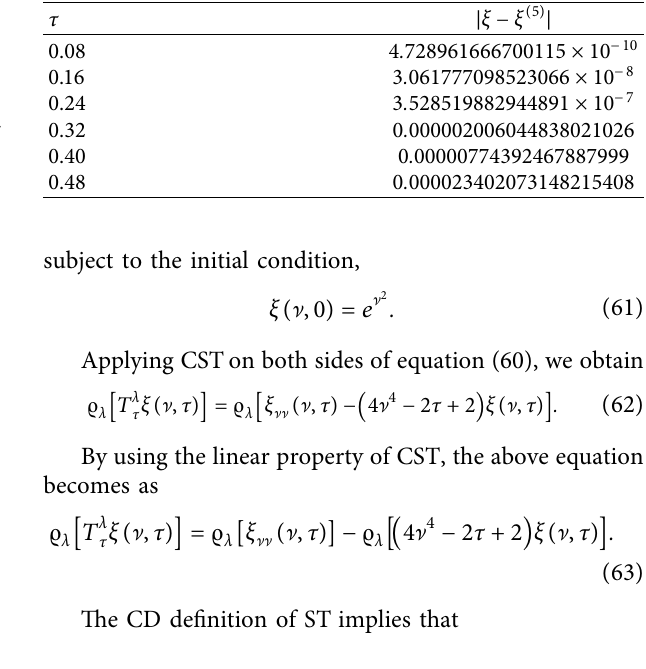
1 with ] 0 . (cid:29) (cid:29)